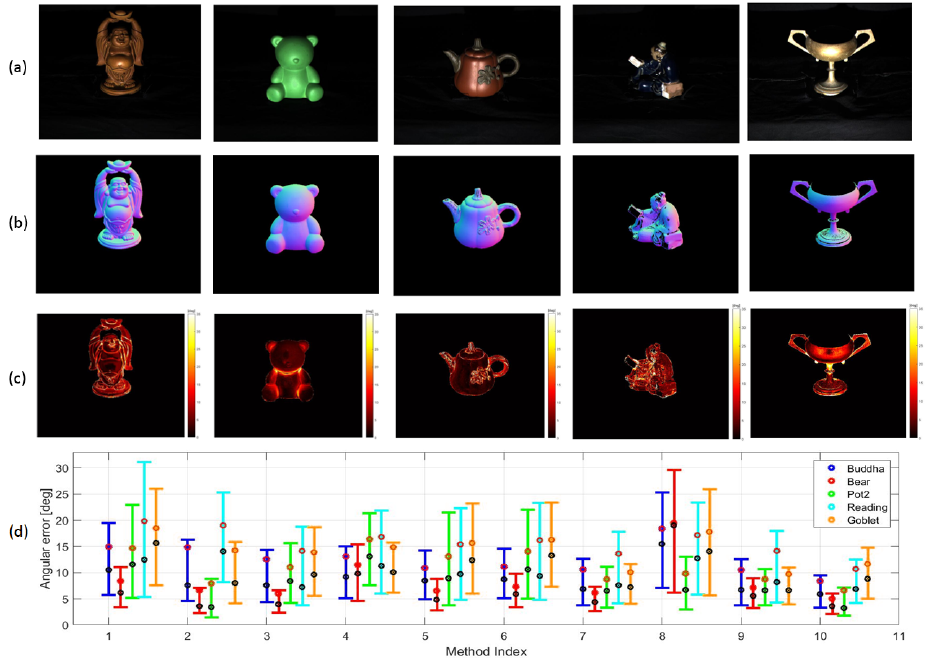
Figure 6. Evaluations on surface oreintation estimation: ( a ) Image irradiance under the first illu- minant; ( b ) Estimated normal map; ( c ) Angular error of surface orientations; ( d ) Angular error of surface orientations on five datasets using ten different PS